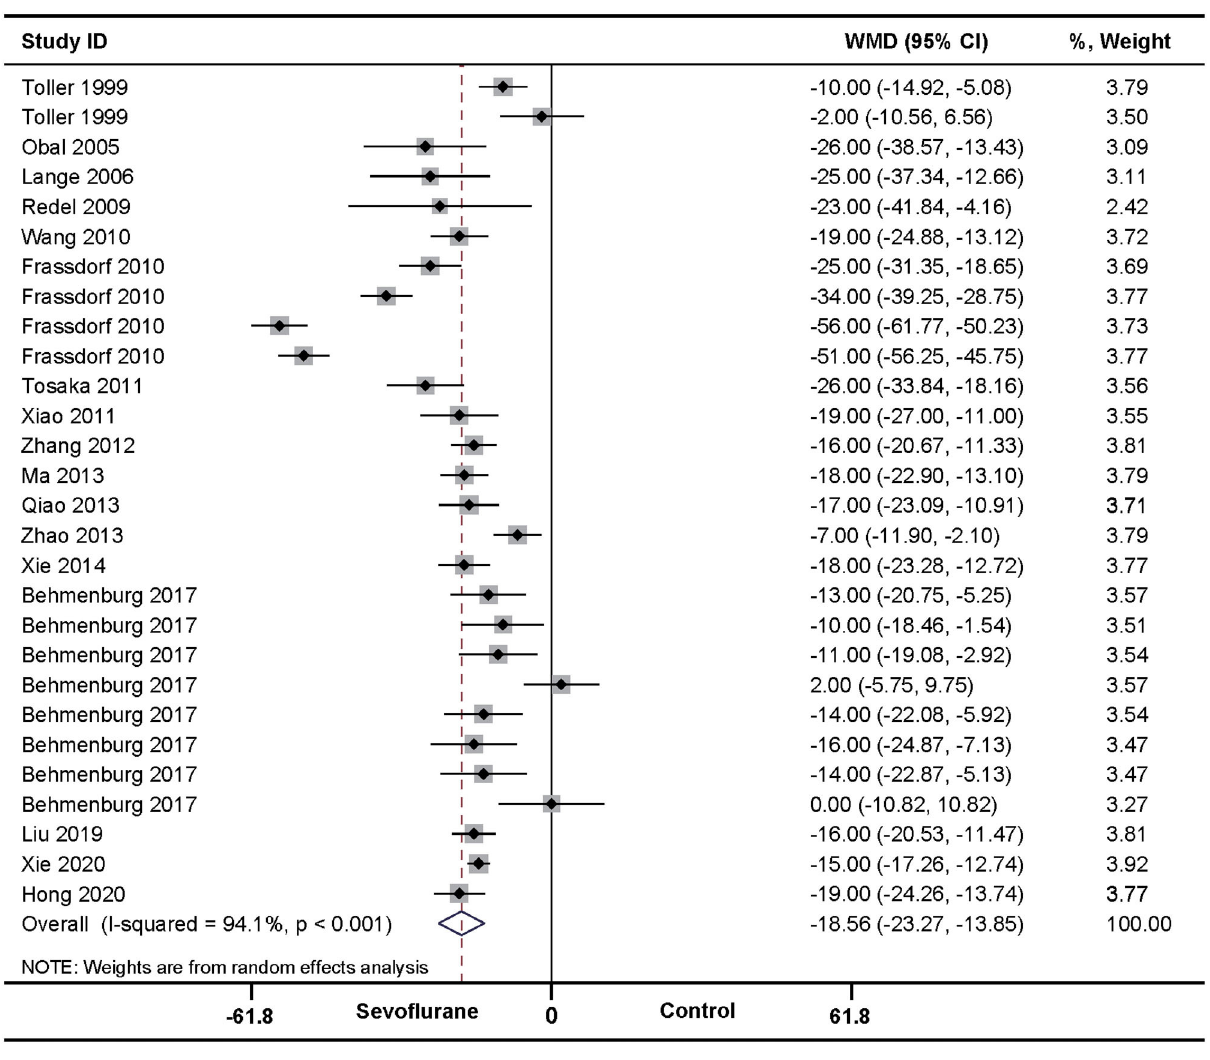
FIGURE 2 | Pooled estimates of infarct size for sevoflurane preconditioning (SPreC) vs. control. Forest plots of meta-analysis of SPreC on myocardial infarct size pooled using a random-effects meta-analysis. The study ID is represented by last name of first author and year of publication. If a study ID is repeated, it indicates that same study involves different intervention protocols. Please refer to the details of intervention protocols in Table 1A .